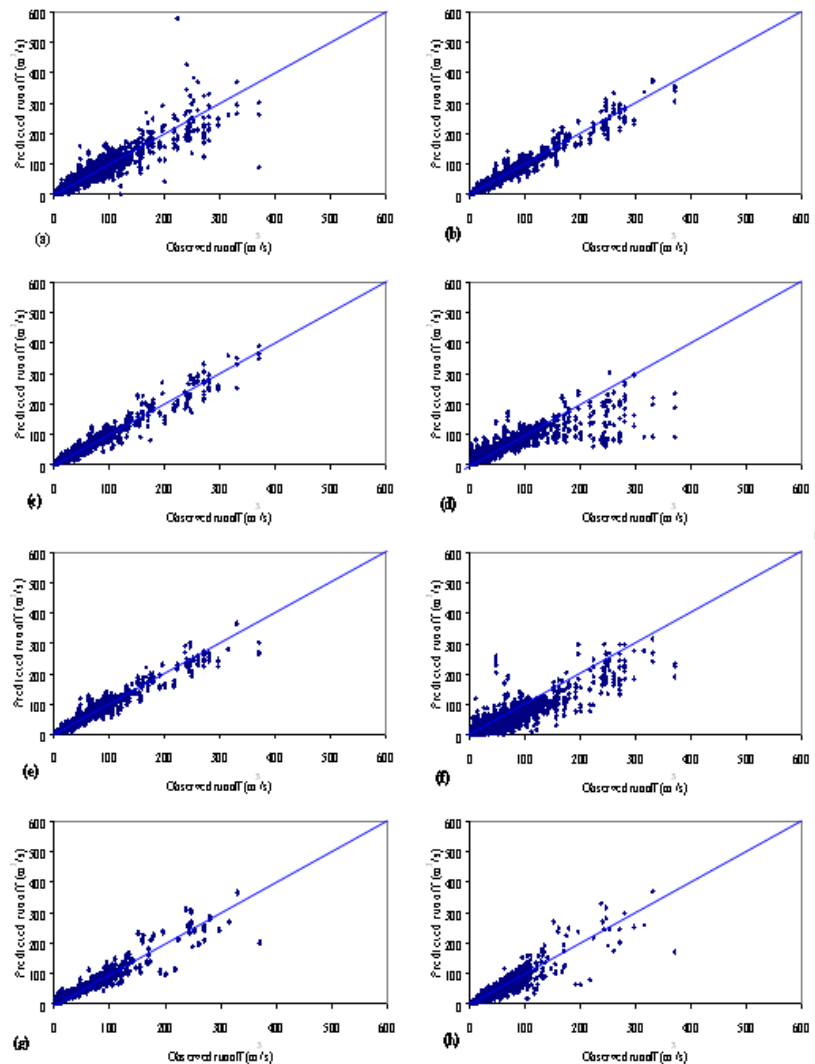
Fig. 11. scatter plots of observed and predicted runoff II, (a) ANNs, (b) GP, (c) EPR, (d) SVM, (e) M5, (f) K-nn, (g) MLR, and (h) naive.